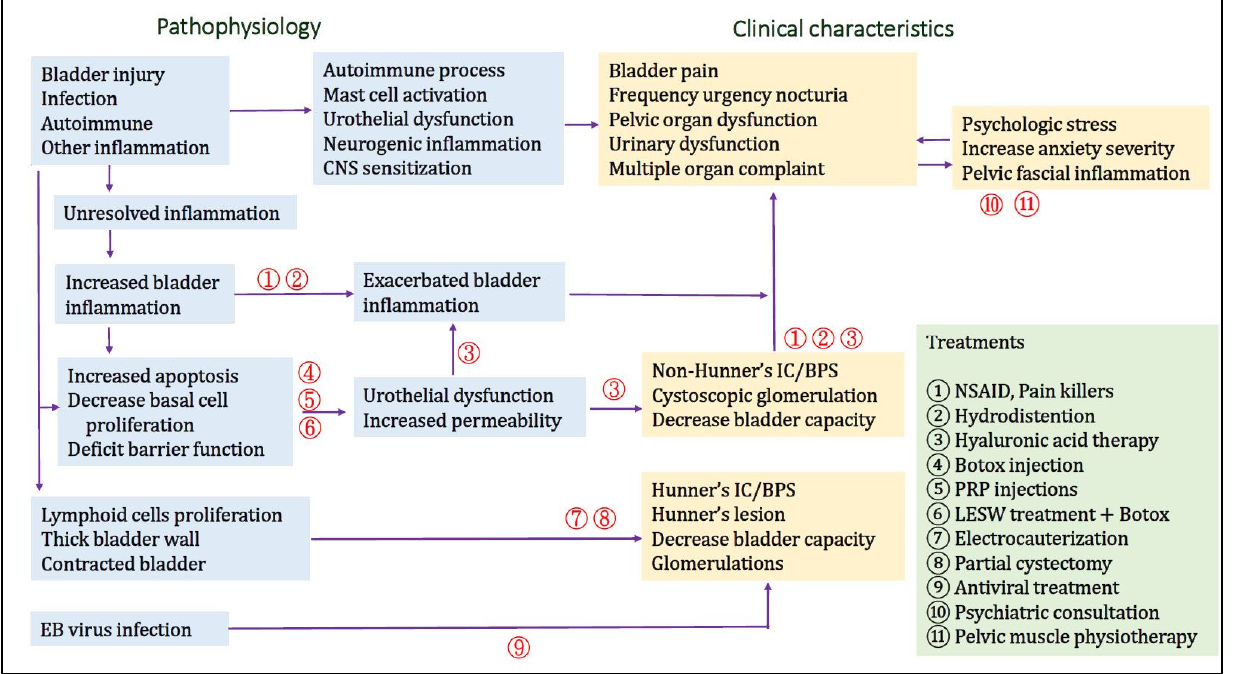
Figure 4. Schematic flow chart of the pathophysiology of interstitial cystitis/bladder pain syndrome (IC/BPS) and the treatments targeting at individual pathophysiology. The number of treatments showing in the diagram indicates the site of treatment targeting at the possible pathophysiology of IC/BPS.